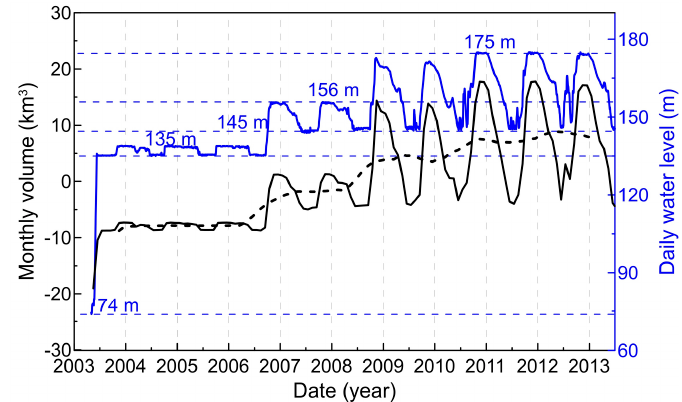
Figure 3. In-situ daily water level (blue solid curve) and monthly volume after removed mean volume (black solid curve) in the TGR from 2003 to 2012. The blue dashed lines represent four stages of the TGR filling: prefilling (74 m) and the first (135 m), second (156 m), and third stages (175 m). The black dashed curve is the smoothed TGR prediction.